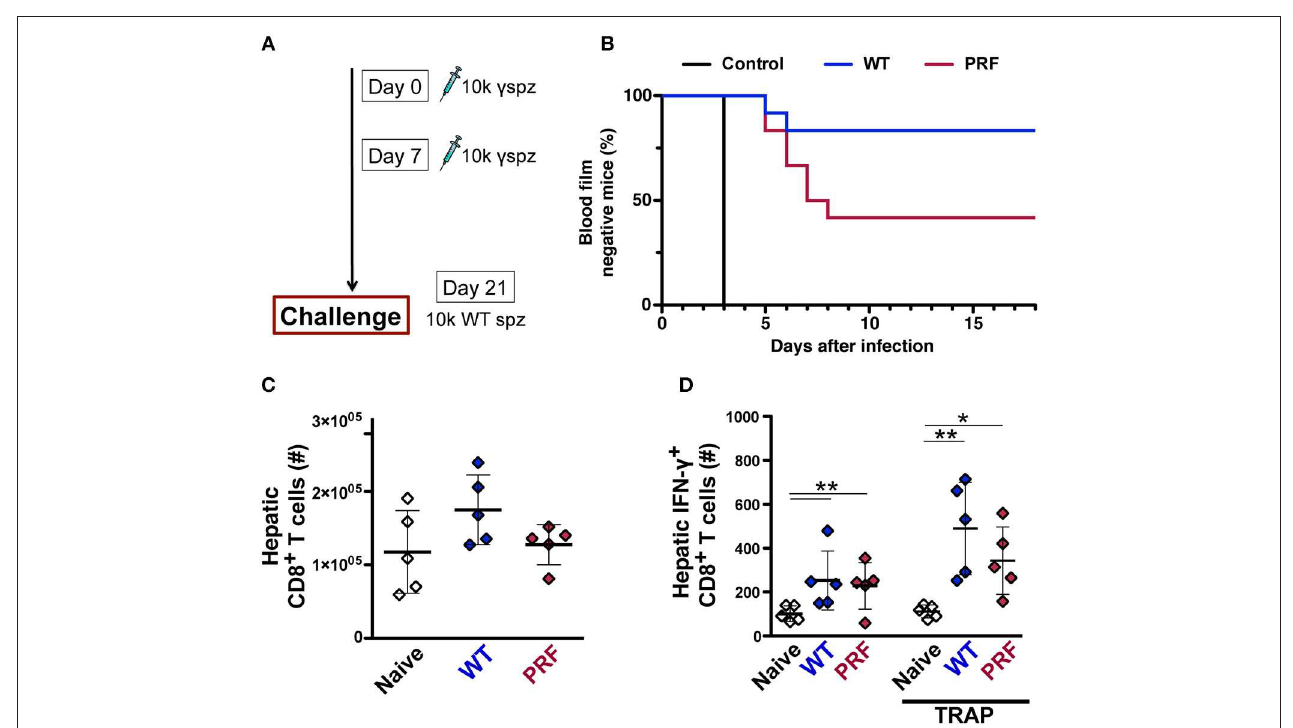
FIGURE 8 | PRF sporozoites do not induce more liver-stage antigen specific CD8 + T cells compared to WT sporozoites upon immunization. (A) Immunization and challenge protocol. C57BL/6 mice were immunized twice at weekly intervals with 10,000 irradiated hemocoel sporozoites (10k γ -spz). Animals were challenged with 10,000 WT salivary gland sporozoites (10k spz) 14 days after the last immunization. (B) Kaplan-Meier analysis of time to blood infection. Naïve mice ( n = 9), WT and PRF sporozoite-immunized mice ( n = 12 each). Blood parasitemia was determined by daily microscopic examination of Giemsa-stained blood films. The statistics for WT vs. PRF sporozoite-immunized mice were non-significant for Log-rank (Mantel-Cox) test. (C) Enumeration of total liver CD8 + T cell numbers after 14 days from the last immunization. Livers were isolated for flow cytometric analysis from naïve and WT and PRF sporozoite-immunized mice ( n = 5). The results represent mean values ( ± SD ). (D) Quantification of IFN- γ -secreting antigen-specific liver CD8 + T after 14 days from the last immunization. Hepatic leukocytes were stained for intracellular IFN- γ production without (left) or after re-stimulation with Pb TRAP 130 − 138 peptide (right). The results represent mean values ( ± SD ). * P < 0.05; ** P < 0.01 (Mann-Whitney